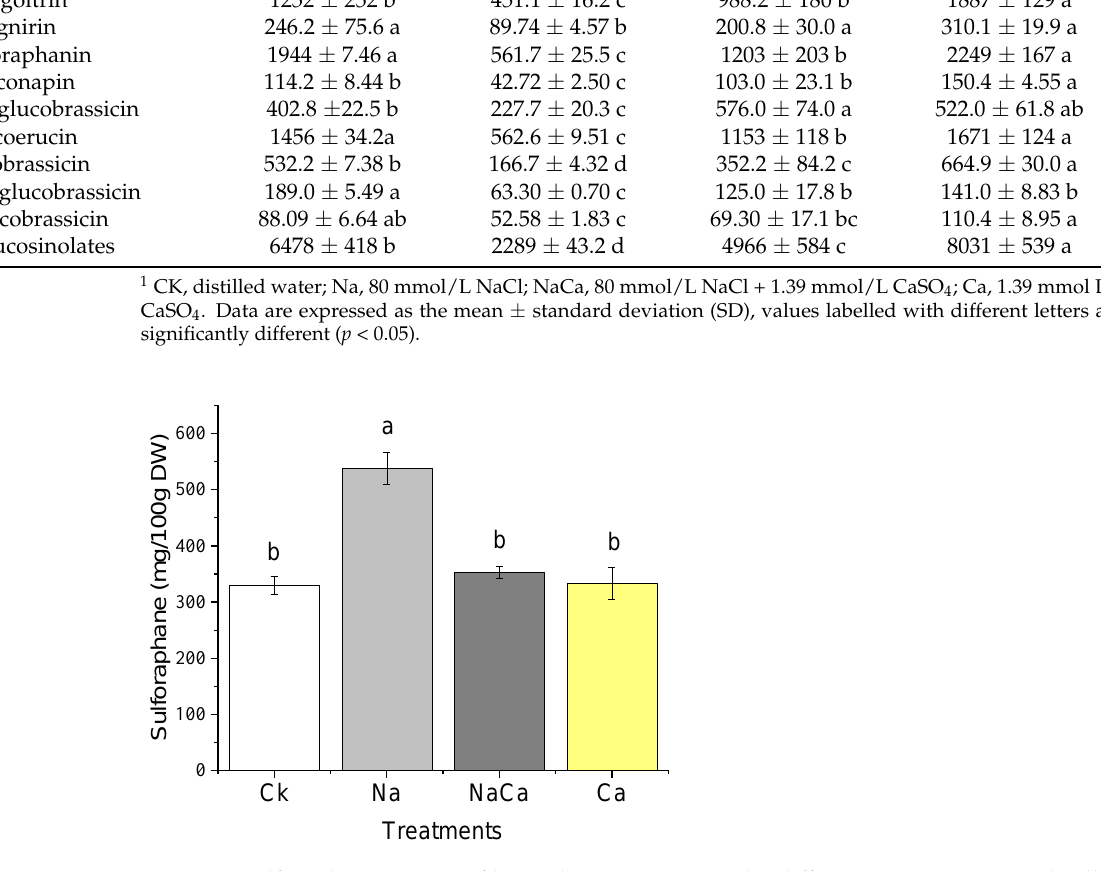
Figure 2. Sulforaphane content of broccoli microgreens under different treatments. CK, distilled water; Na, 80 mmol/L NaCl; NaCa, 80 mmol/L NaCl + 1.39 mmol/L CaSO 4 ; Ca, 1.39 mmol/L CaSO 4 ; DW, dry weight. Data are expressed as the mean ± standard deviation (SD), values labelled with different letters are significantly different ( p < 0.05).